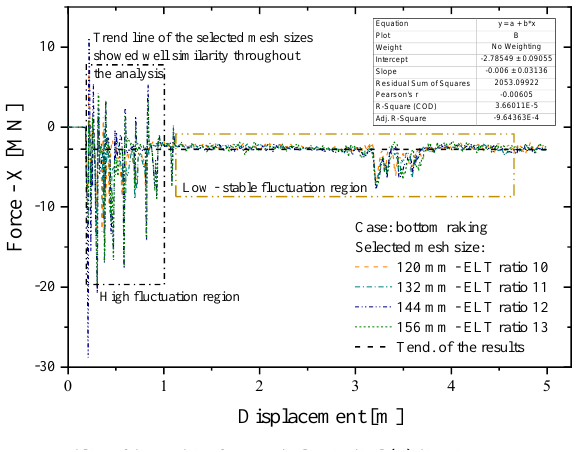
Figure 11. Trend line of the crushing force on the transversal (Y) direction. Figure 11: Trend line of the crushing force on the transversal (Y)